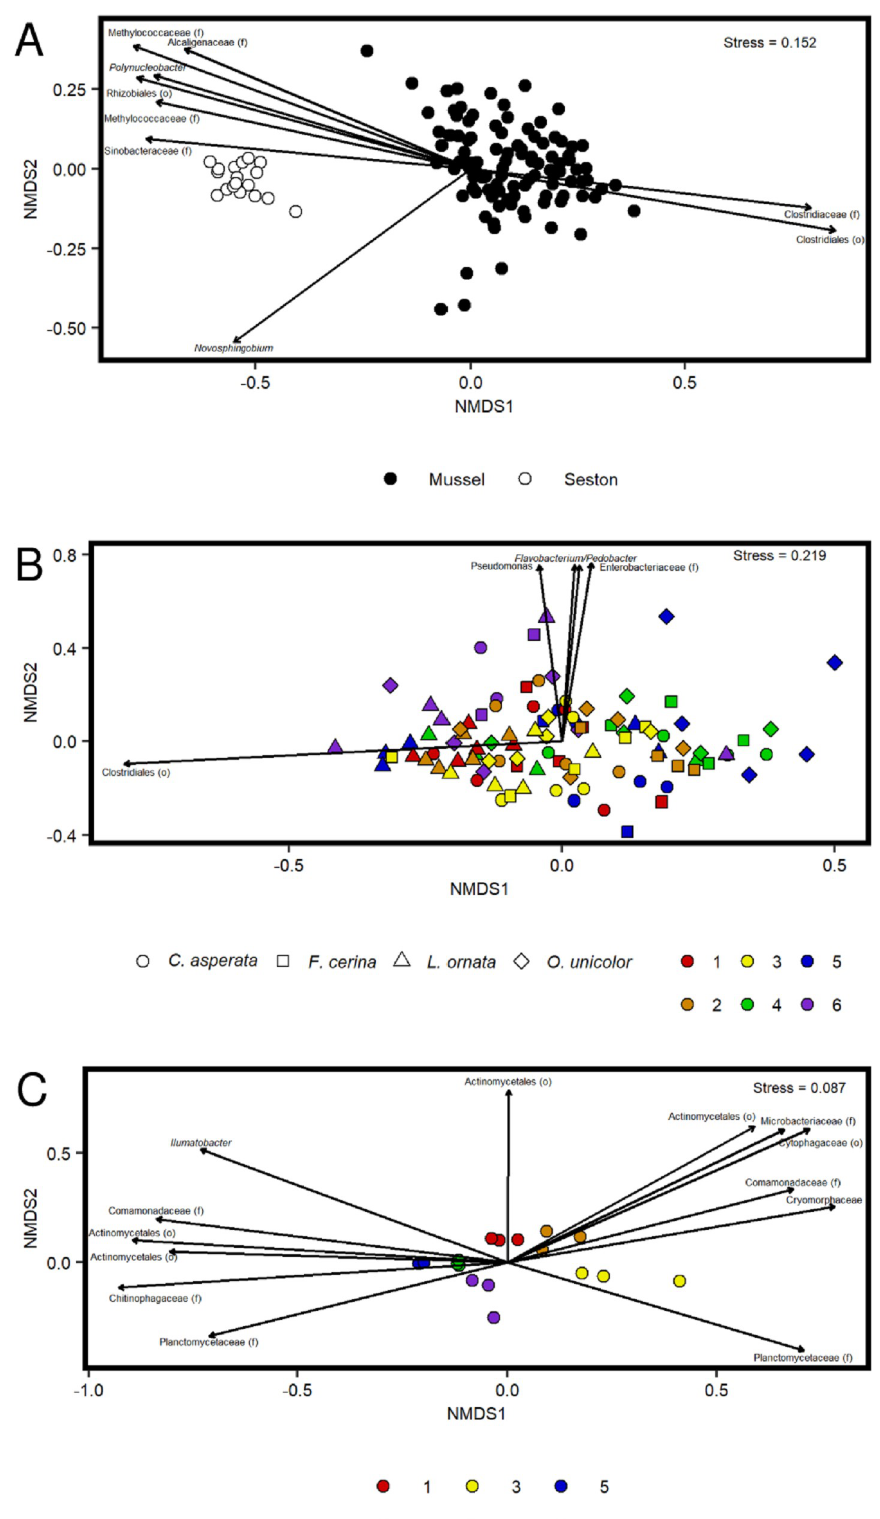
Fig 5. NMDS ordinations of 16S rRNA bacterial microbiome data collected from the mussel species Cyclonaias asperata , Fusconaia cerina , Lampsilis ornata , and Obovaria unicolor from the Sipsey River, AL, USA, in